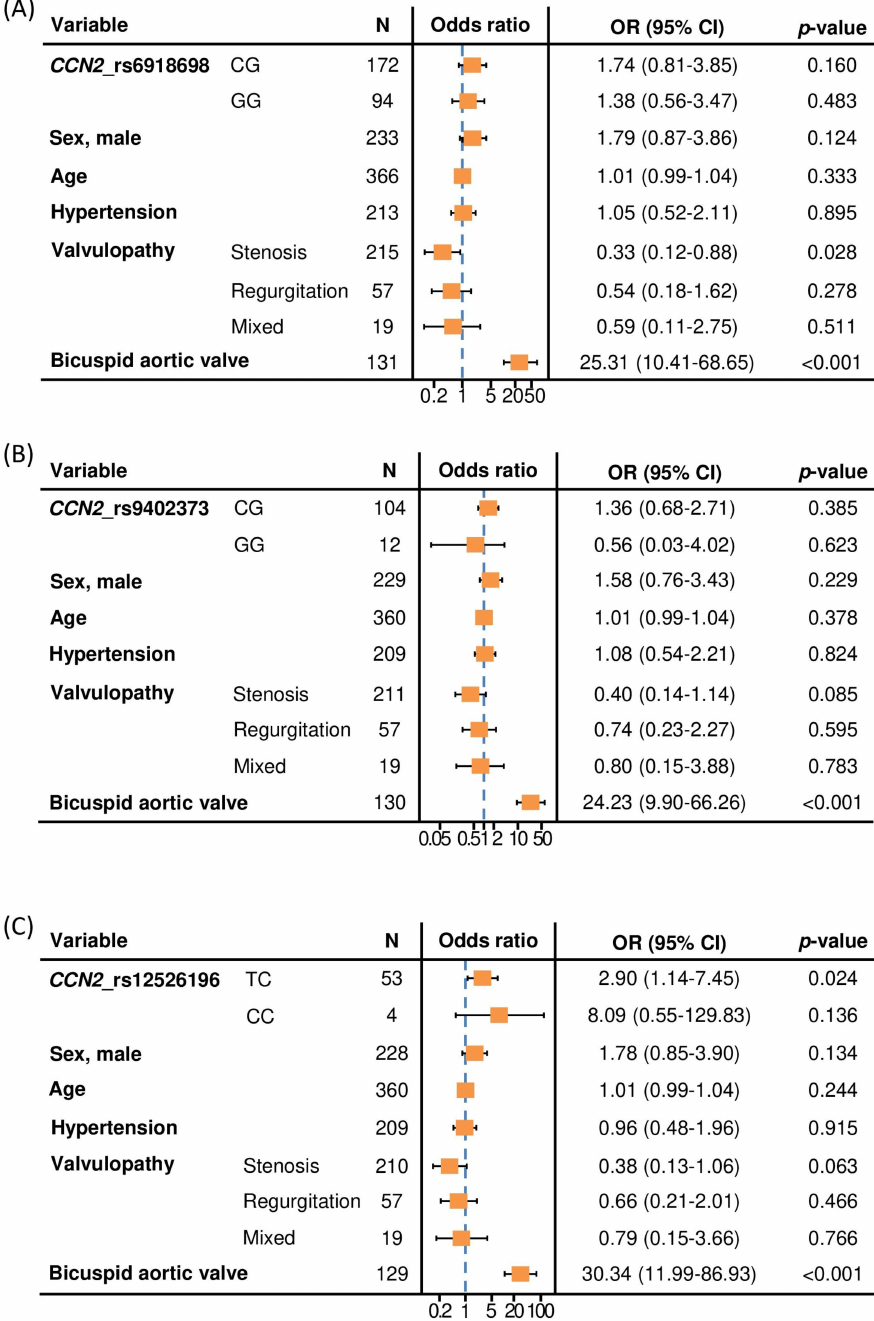
Figure 1. Forest plots showing the multivariable logistic regression models for the association be- tween CCN2 rs6918698 ( A ), rs9402373 ( B ) and rs12526196 ( C ) polymorphisms and the presence of thoracic aortic aneurysm, adjusted for potential confounders. Reference for CCN2_rs6918698 polymorphism: CC genotype. Reference for CCN2_rs9402373 polymorphism: CC genotype. Refer- ence for CCN2_rs12526196 polymorphism: TT genotype. Reference for sex: female. Reference for valvulopathy: normal functioning valve. Reference for bicuspid aortic valve: tricuspid aortic valve. N = number of patients. OR (95% CI): Odds ratio (95% confidence